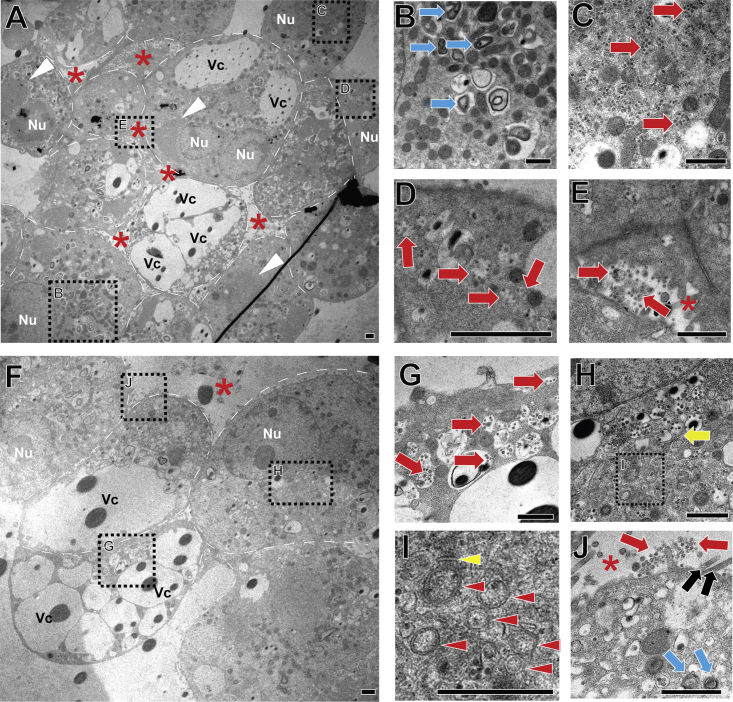
Transmission Electron Microscopic Imaging Analysis of SARS-CoV-2-Infected h3ACs at 2 Days after Infection(A) Low-magnification representative image of infected h3ACs (n = 10 h3ACs from three donors; P2–P3). Red asterisks, alveolar space; white arrowheads, aggregated viral particles; white dashed line, hAT2 cell membrane. Vc, large pathologic vacuoles; Nu, nucleus.(B) Lamellar bodies (blue arrow) are observed.(C) hAT2 cells with a high density of SARS-CoV-2 particles. Viral particles are dispersed in a cytoplasm of the cell (red arrow).(D) Multiple viral particles included in the vesicular structures (red arrow).(E) Virus particles secreted to the lumen of the h3AC.(F) Partial image of another infected h3AC.(G) Virus particles encapsulated in vesicular structures (red arrow).(H) Virus-containing vesicles aggregated in the vicinity of ER (yellow arrow).(I) Double-membrane vesicles (red arrowhead) located near zippered ER (yellow arrowhead).(J) Viral particles secreted into the lumen of a h3AC (red arrows). Microvilli (black arrow) are shown at the apical side of a hAT2 cell.Scale bars, 1 μm.